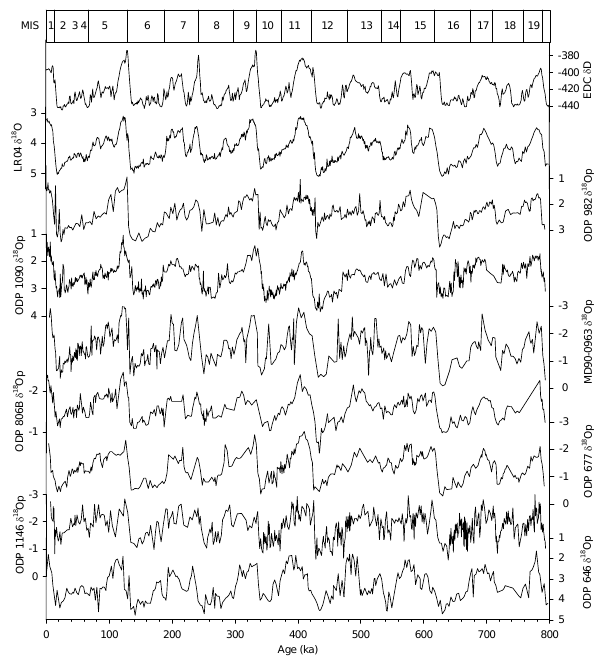
Fig. 2b. Planktonic δ 18 O records aligned to the LR04 benthic stack, with corresponding marine isotope stages (MIS) from LR04; EDC δ D on EDC3 timescale.